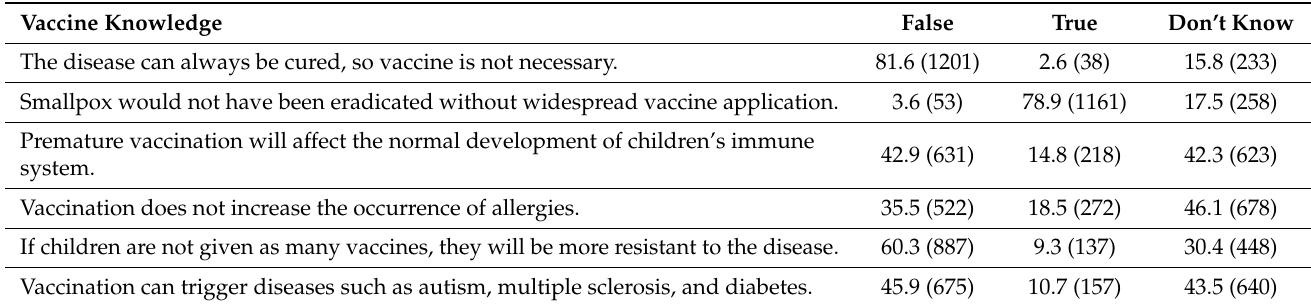
Table 10. Participants’ vaccine knowledge ( n = 1472).